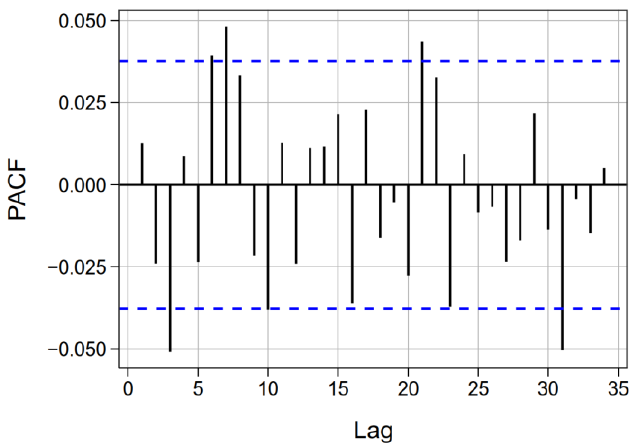
Figure 3. Partial autocorrelation function (PACF) of the residuals at daily lags of the PM 10 model developed for the air quality monitoring station IT0470A — Torino Rebaudengo.